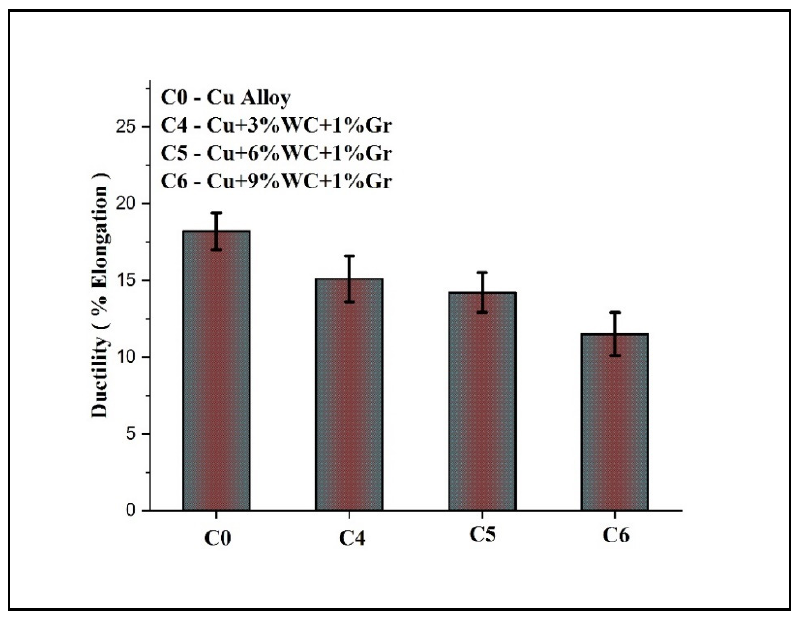
Figure 16. Variation % elongation of Cu alloy and Cu-(3, 6, 9) wt.% WC-Gr hybrid composites.